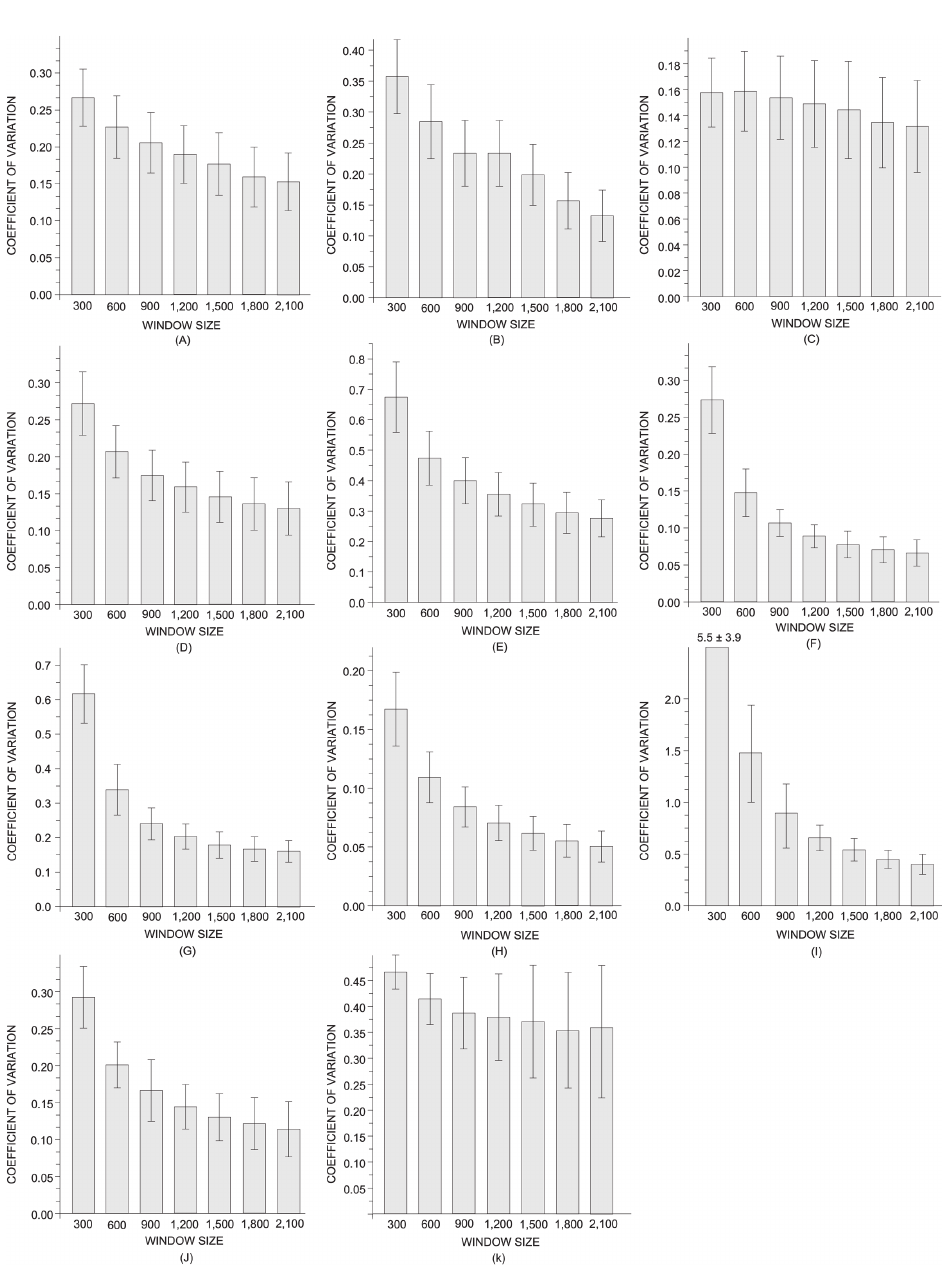
Fig 2. Coefficient of variation for complex network measurements. The measurements considered were (a) average acessibility h α ( h = 2) i ; (b) average acessibility h α ( h = 3) i ; (c) average neighbors degree h k n i ; (d) average betweenness h B i ; (e) average clustering coefficient h C i ; (f) average intermittency h I i ; (g) standard deviation of the intermittency Δ I ; (h) skewness of the intermittency γ ( I ); (i) average shortest path length h l i ; (j) standard deviation of the shortest path length Δ l ; and (k) skewness of the intermittency γ ( I